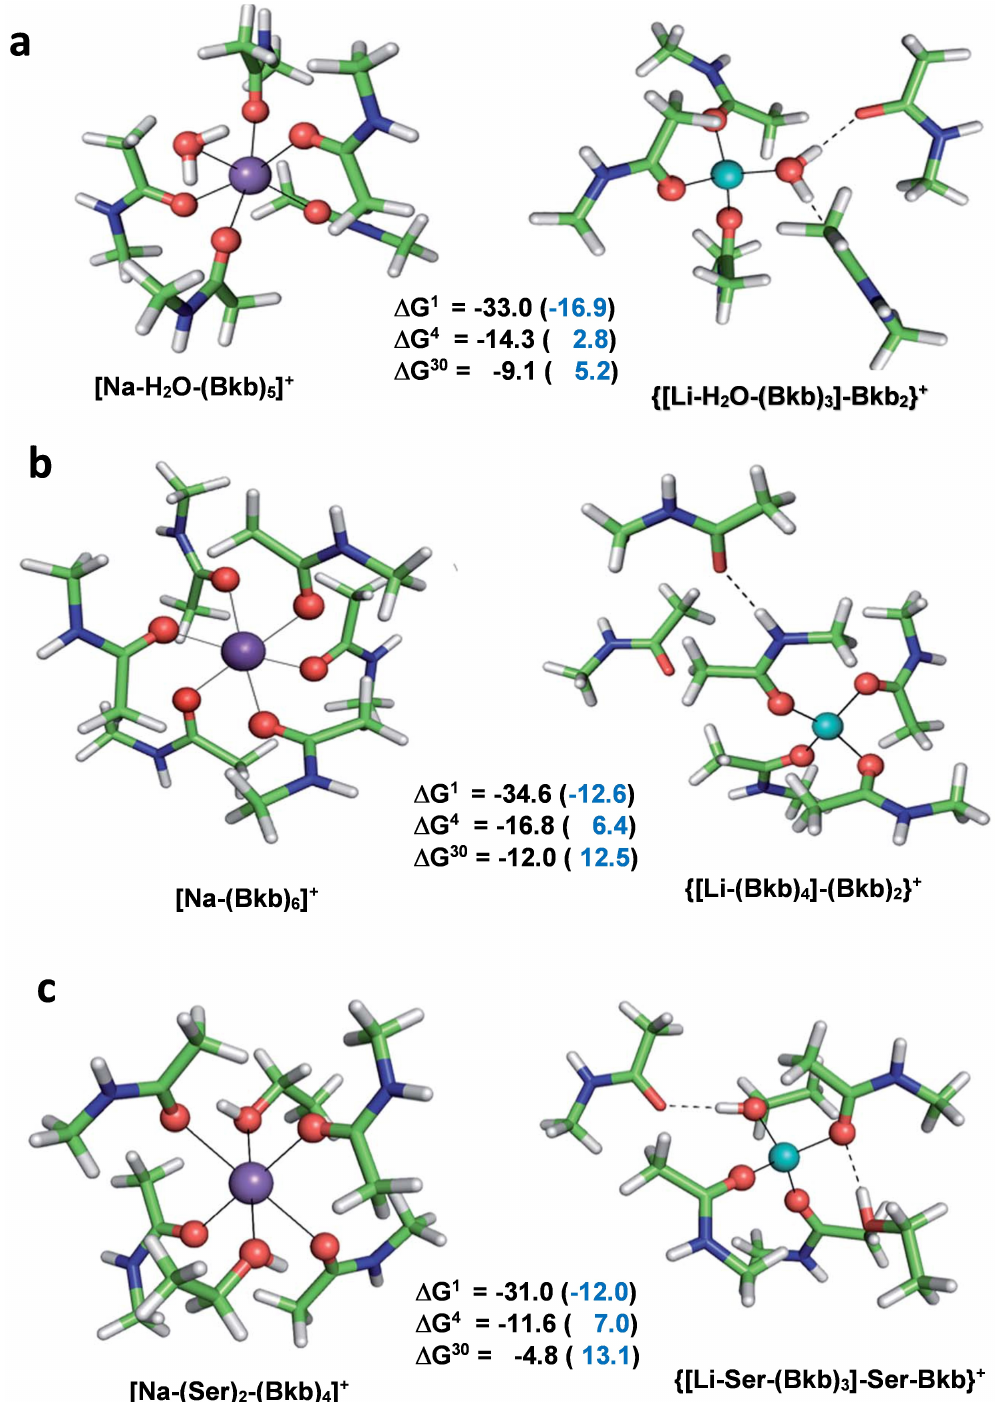
Figure 4. Calculated Gibbs free energies for the Na + → Li + exchange (in kcal/mol) and B3-LYP/6- 31+G(3d,p) fully optimized structures of Na + (purple) and Li + (turquoise) complexes with ( a ) a water molecule and 5 backbone ligands; ( b ) 6 backbone ligands, and ( c ) 4 backbone and 2 serine ligands. ∆ G 1 refers to cation exchange free energy in the gas phase, whereas ∆ G 4 and ∆ G 29 refer to cation exchange free energies in an environment characterized by an effective dielectric constant of 4 and 29, respectively. Free energies for the metal exchange in rigid binding sites are given in parentheses. Positive numbers suggest Na + -selective sites, whereas negative free energies imply the opposite. Backbone peptide groups are modeled as CH 3 CONHCH 3 and the side chains of Ser are represented as CH 3 CH 2 OH. Adapted from Ref. [60]. Copyright 2018 Royal Society of